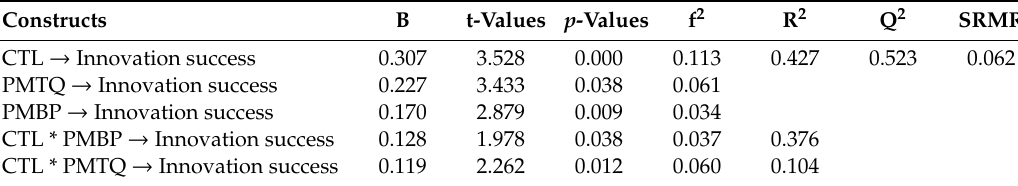
Figure 4. Moderating effects of PMTQ. 5. Conclusions The present study empirically examined the effects of CTL, PMBP, and PMTQ on innovation success in the ICT industry in South Korea. Although prior research has extensively explored transformational leadership and its effect on a variety of innovation-based outcomes, apart from innovation success, the current study provides empirical evidence that CTL, PMBP, and PMTQ have a significant positive effect on innovation success. In addition, the findings support that PMBP and PMTQ can significantly moderate CTL and innovation success [1,2,6]. Besides the development and validation of a new scale (i.e., PMTQ), the study findings provide practical insights for project practitioners, innovation managers, and organizations leaders to integrate PMBP and PMTQ in their work settings, especially in highly volatile and uncertain business environments. Study findings also suggest that PMBP and PMTQ can amplify the impact of CTL to create opportunities that break the barriers towards innovation success [1,2,6]. 5.1. Discussion The current study had two objectives. First, to extend and empirically examine a conceptual model that measures the impact of CTL, PMBP, and PMTQ on innovation success in the ICT industry